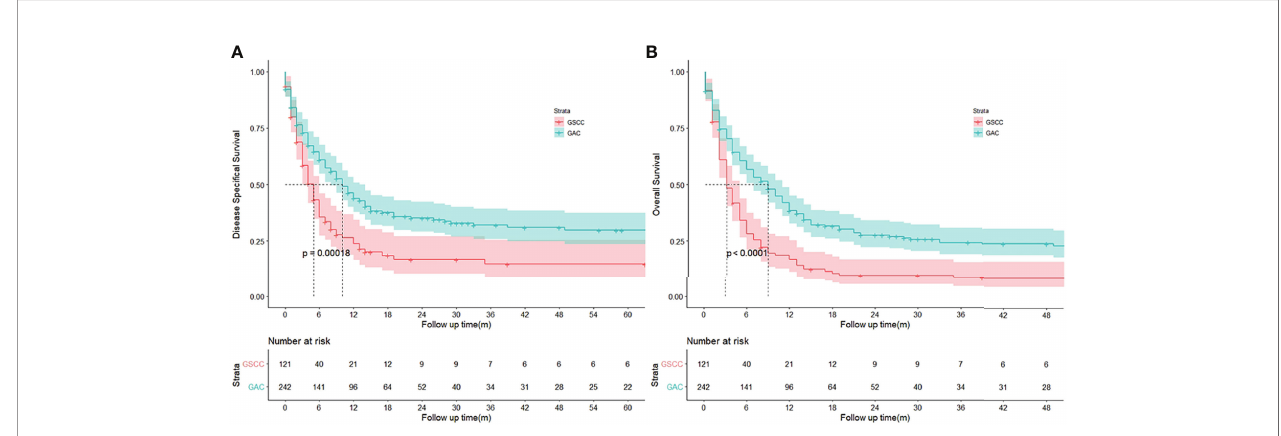
FIGURE 3 | (A, B) Kaplan ‐ Meier curves to compare disease speci fi cal survival (DSS) and overall survival (OS) of patients with gallbladder squamous cell carcinoma (GSCC) and gallbladder adenocarcinoma (GAC),